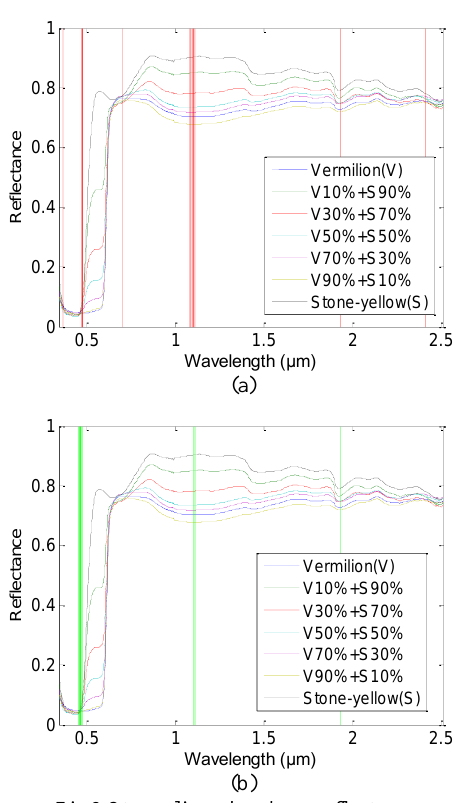
Fig.3 Strong linear bands on reflectance spectral (a) ： strong linear bands of vermilion ； (b) ： strong linear bands of stone yellow